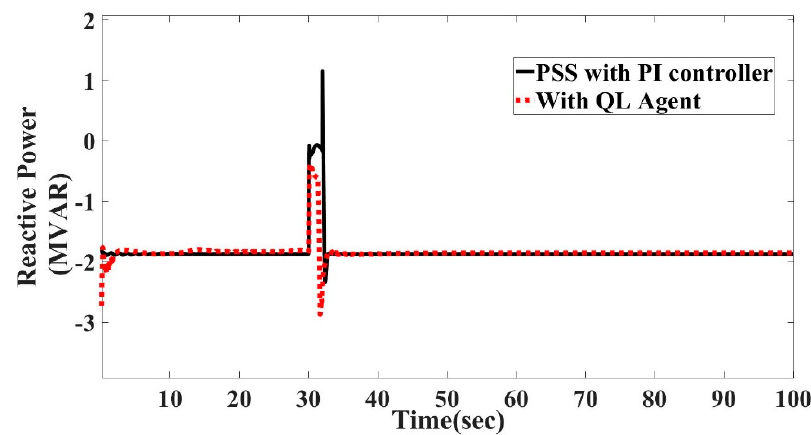
Figure 26. Active power with PI controller vs. Q-learning under fault. Figure 26 . Active power with PI controller vs. Q ‐ learning under fault.